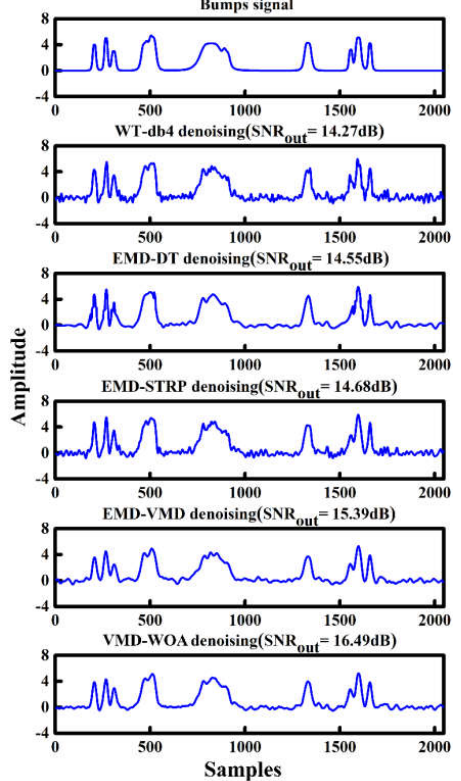
Figure 6. Comparisons of different denoising techniques for the noisy Bumps signal. WT is